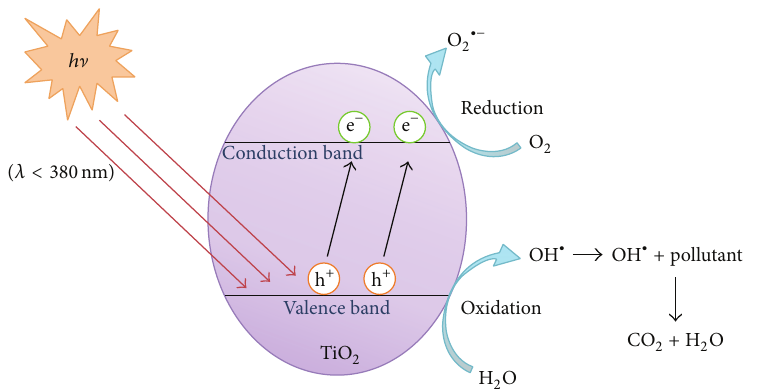
Figure 1: General mechanism of the photocatalysis [13]. Table 1: Typical synthetic methods of 1D TiO